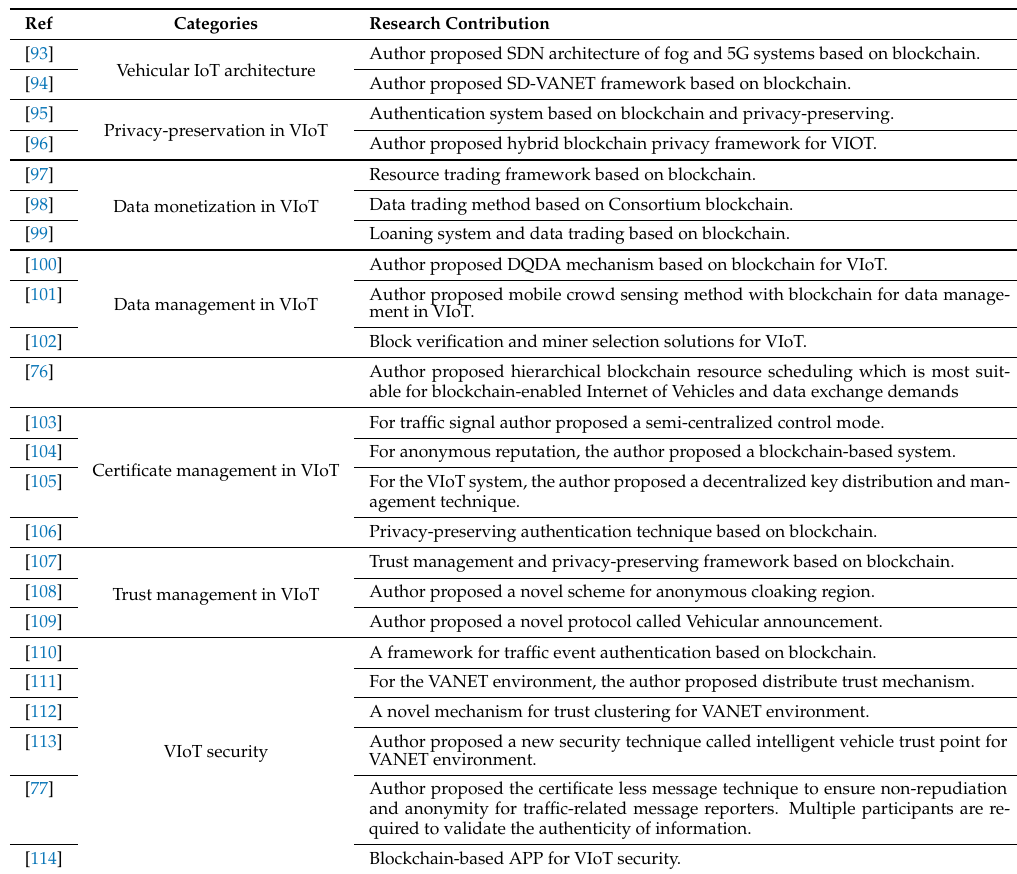
Table 1. Integration of vehicular internet of things and